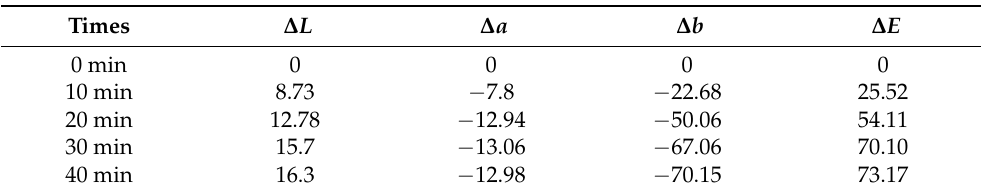
Table 1. Time-dependent color changes of MO solution using Gd 2 O 3 -ZIF-8 nanocomposites as photocatalyst.